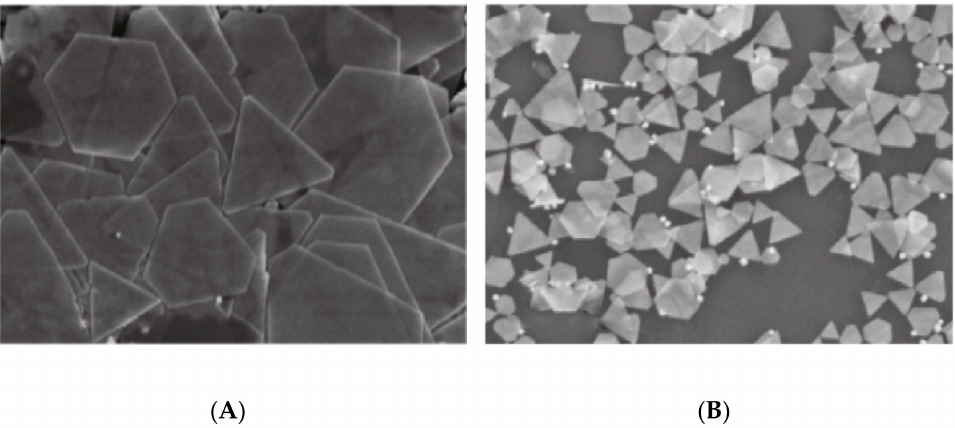
Figure 5. SEM images of gold nanoplates synthesized using yeast extract at different pH conditions. ( A ) Au nanoplates at low pH without NaOH, ( B ) small Au nanoplates synthesized at high pH. Reprinted with permission from Reference [131]. Copyright 2016 Springer